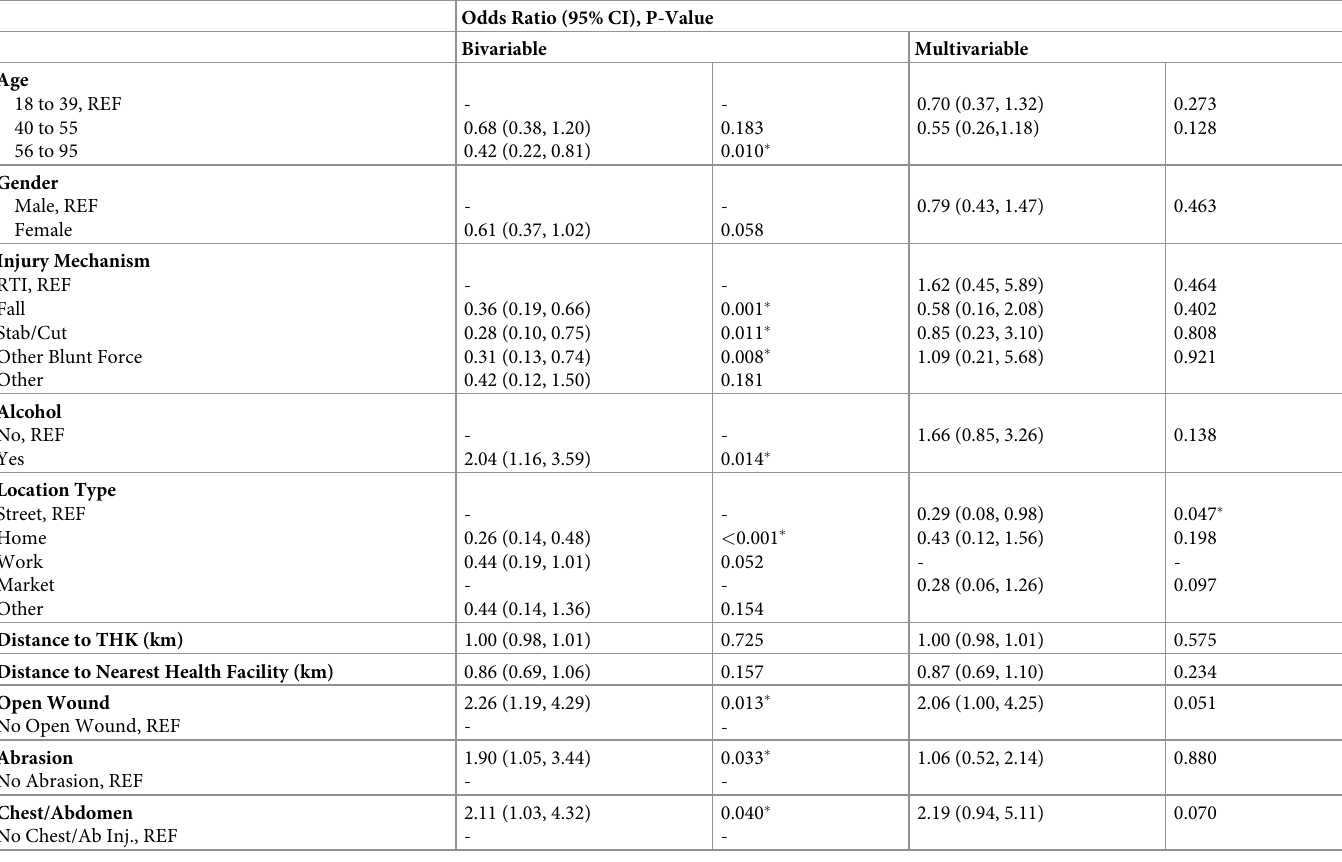
Table 4. Predictors of ambulance transport to first health facility: Logistic regression